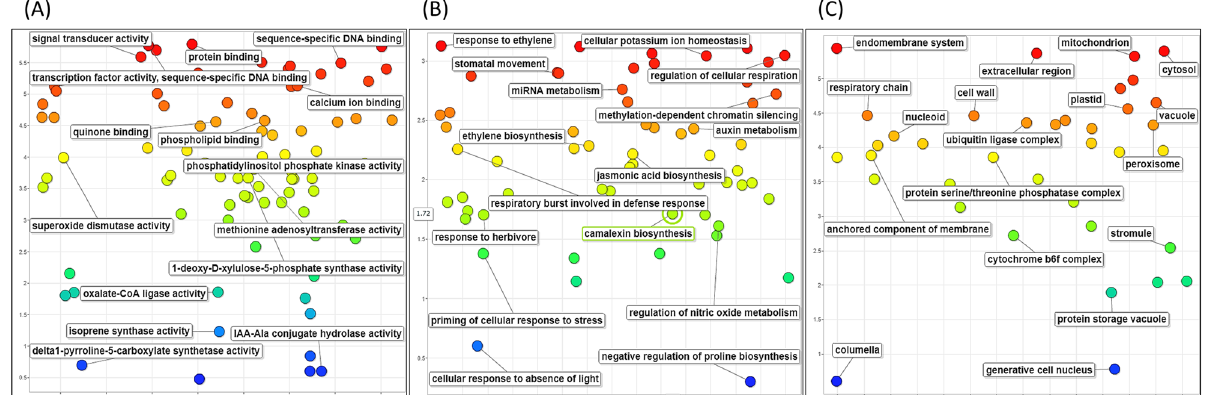
Figure 5. Scatter plot of the GO enrichment for DEGs in response to mechanical wounding in D. cymosum . Enriched DEGs were classified into the ( A ) molecular function ( B ) biological process and ( C ) cellular component categories. The plot is based on the frequency of the GO terms rather than representing the actual regulation of each gene. The log count is shown on the y-axis. Semantic space is represented on the